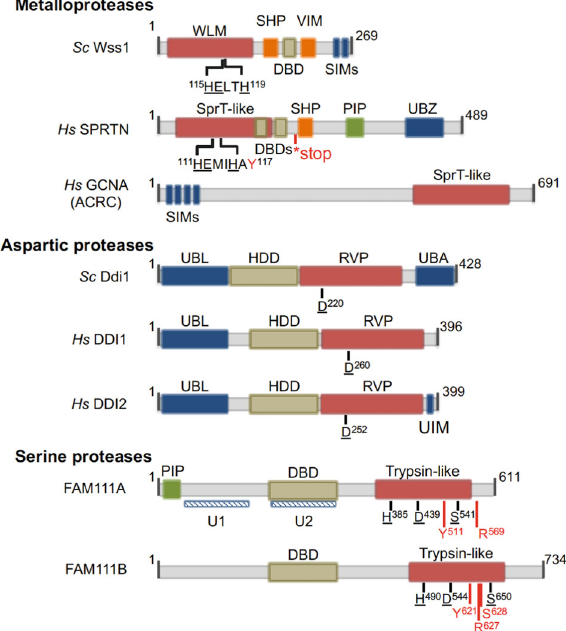
Fig. 2 The structural features of the known DPC proteases. Domains/ motifs for interactions are color-coded. Red: protease domains. Orange: Cdc48/p97 interaction. Green: PCNA interaction. Ochre: DNA binding. Blue: SUMO/ubiquitin/proteasome binding. The catalytic residues in the protease domains are underlined. The sites of disease-associated mutations in SPRTN (RJALS) 60 , FAM111A (KCS2) 118,119 , and FAM111B (POIKTMP) 47 are marked in red. The asterisk in SPRTN indicates the site of nonsense mutations in RJALS patients that generate the protein SPRTN- Δ C 60 . RVP, retroviral protease. U1 and U2, potential UBLs in FAM111A 61